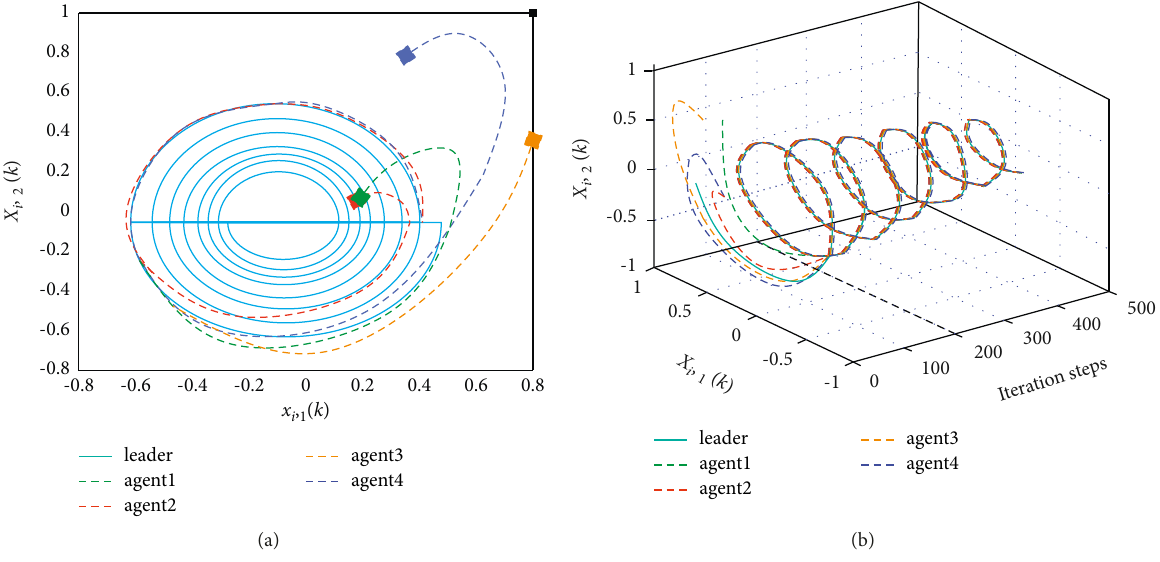
Figure 6: State evolution trajectories of all agents. (a) 2D phase plan. (b) 3D phase